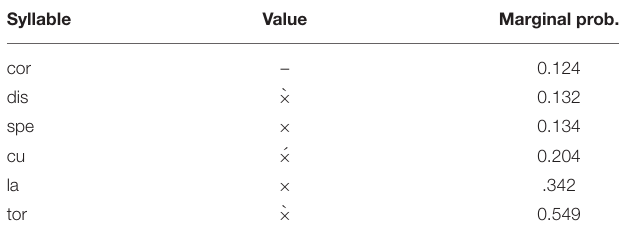
TABLE 6 | Example (6), average probability 0.247.